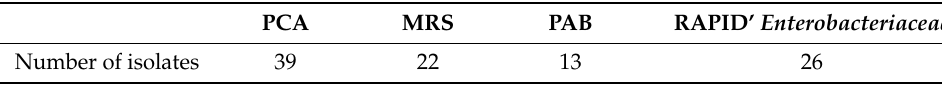
Table 2. Number of isolates collected per culture medium. PCA Number of isolates